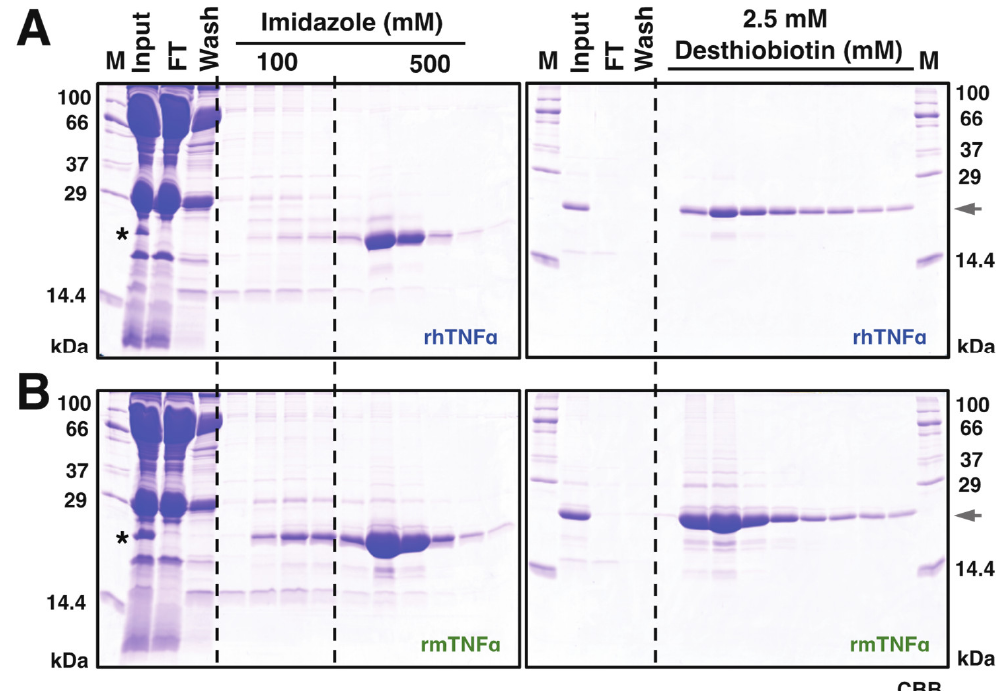
Figure 2. Purification of recombinant hTNF α ( A ) and mTNF α ( B ). Sera of rBmNPV-infection silkworm larvae were collected and treated as described in the Materials and Method section, which were further utilized for protein purification processes. A two-step purification procedure was performed via Nickel (His-Trap, ( A , B ), left panel) and Strep-Tactin (( A , B ), right panel) affinity chromatography. M: molecular mass markers; FT: flow-through; Elution fractions from HisTrap purifications were further used in Strep-Tactin affinity chromatography. Protein samples were resolved on a 15% SDS-PAGE visualized by Coomassie Brilliant Blue (CBB) R-250. The asterisk indicates the visible band of expressed TNF α proteins from collected hemolymph samples. The arrowhead points out the expression of recombinant TNF α proteins.